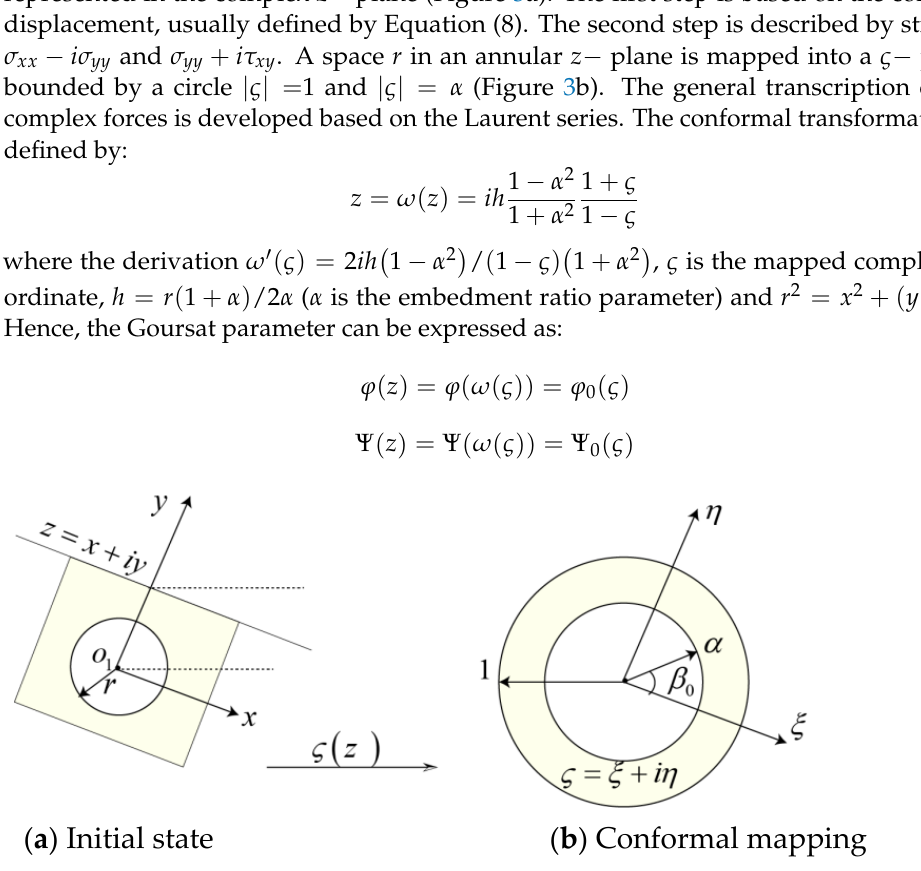
Figure 3. Conformal mapping of a tunnel beneath an inclined plane.